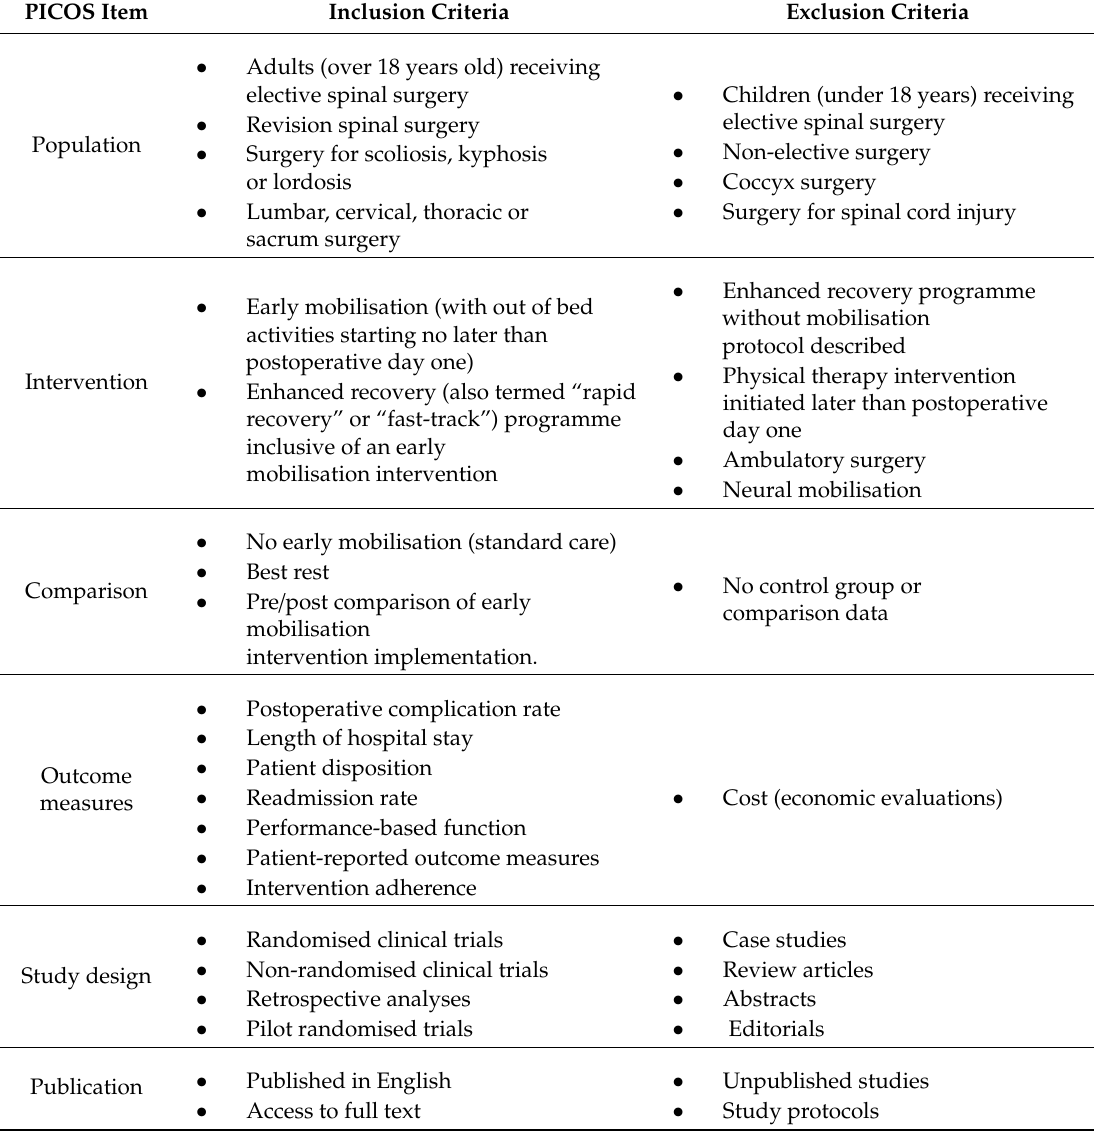
Table 1. PICOS (Population, Intervention, Comparison, Outcome measures, Study design)